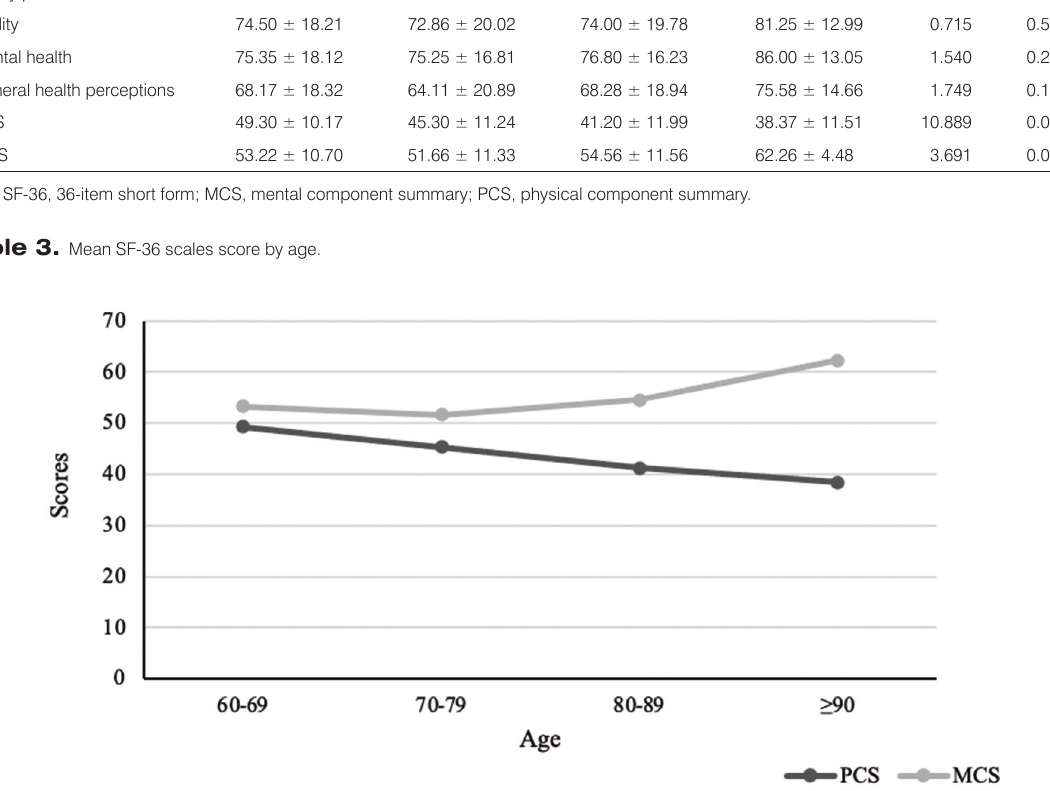
Dependent variable